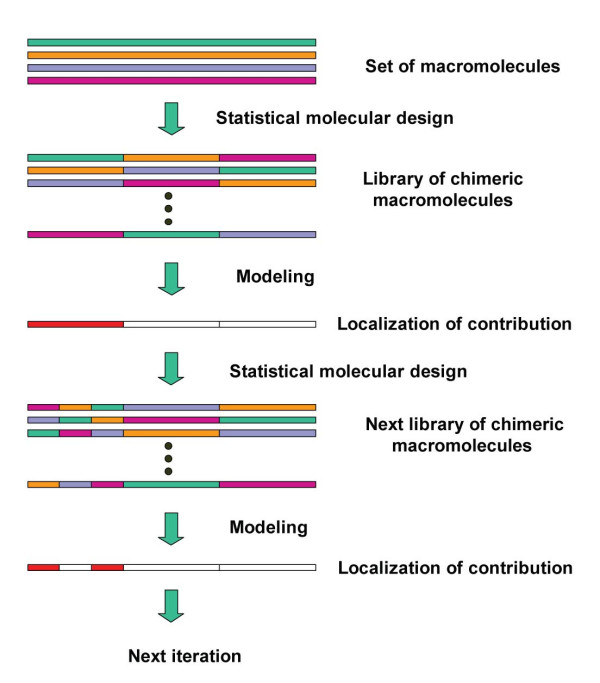
Outline of the mapping of direct and indirect interactions in molecular recognition using proteochemometrics. Outline of a general procedure for mapping molecular recognition by biomacromolecules. Initially, sets of wild-type macromolecules are identified. Using statistical molecular design a library is then created from the wild-type macromolecules. The library can be selected from the wild-type molecules if the initial collection contains sufficient chemical variation. Chemical variation may also be introduced artificially by mutagensis. Shuffling sequence fragments can then be used to create a library, where three or more segments and three or more macromolecules are used as the starting point. After evaluating the interaction of the library with a suitable library of ligands of interest, a proteochemometric model can be created. This model may be used to localize the regions in each macromolecule that contribute to the selectivity of each particular ligand evaluated. It may happen that it is not possible to unambiguously localize individual amino acids within a particular region, due to co-varying amino acid positions in the macromolecular library. In that case, an extension of the library can be made in order to resolve the ambiguity.